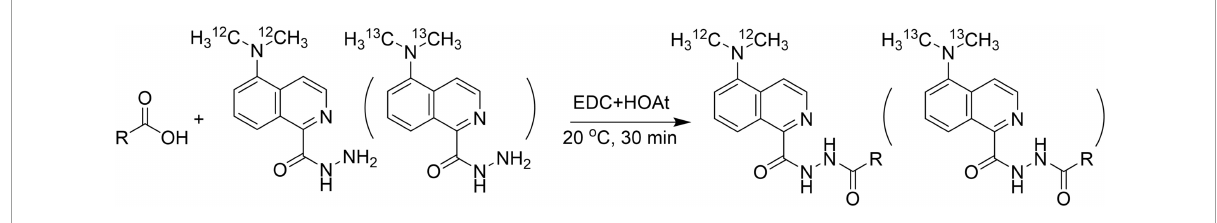
FIGURE1 The reaction mechanism of carboxylic group with 5-(dimethylamino)-1-carbohydrazide-isoquinoline (DMAQ) under mild